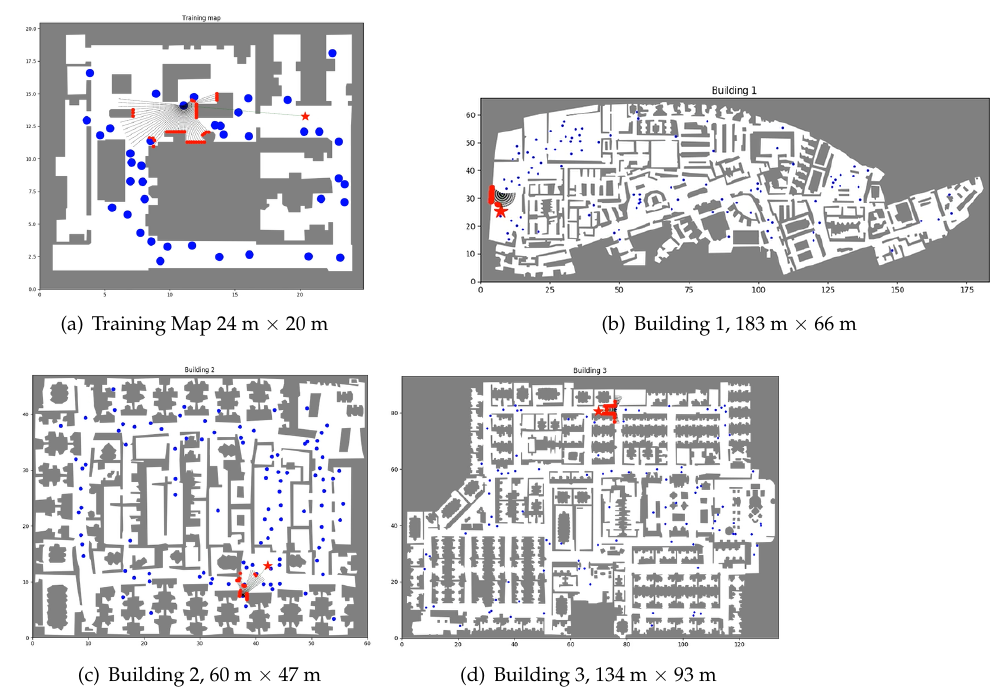
Figure 4. Floor maps. These are the floor maps for training and evaluation with their sizes in